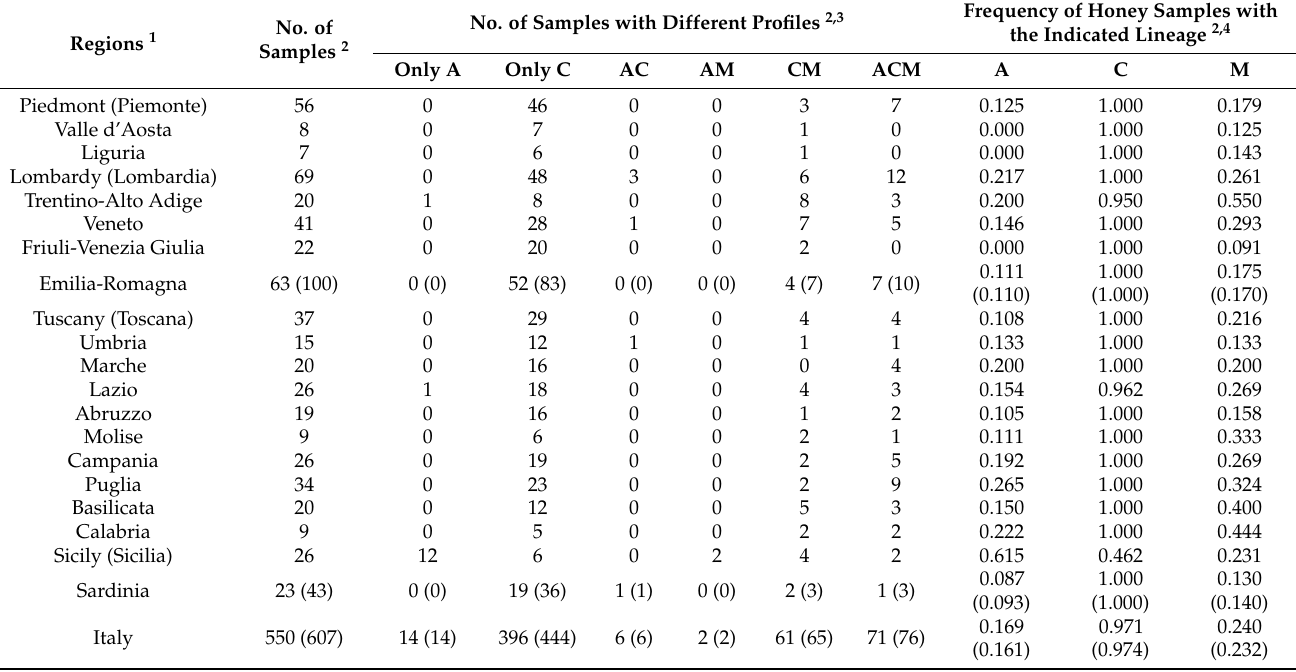
the frequency of the honey samples with different mitotype patterns positioned in the administrative map, with the indication of the 20 Italian regions listed in Table 1. Table 1. Summary results provided for the 20 Italian regions about the number of honey samples that showed different mitotype patterns and about the frequency of samples carrying at least one of the three main groups of mitotypes (A, C and M). Results have been reported including “unique” and “redundant” samples for the Emilia-Romagna and Sardinia regions. Regions